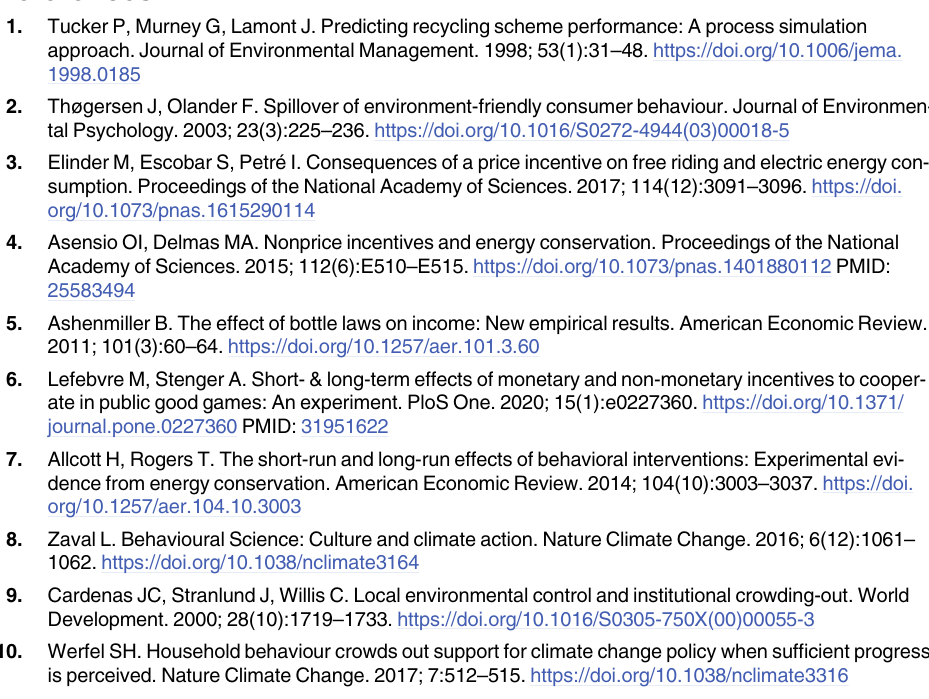
S6 Table. Test for publication bias. S7 Table. Meta regression results. S8 Table. Classifications of dependent variable. S9 Table. Mixed-effect meta regression results with subgroups of dependent variable. S10 Table. Summary survey table for meta-analysis of pro-environmental